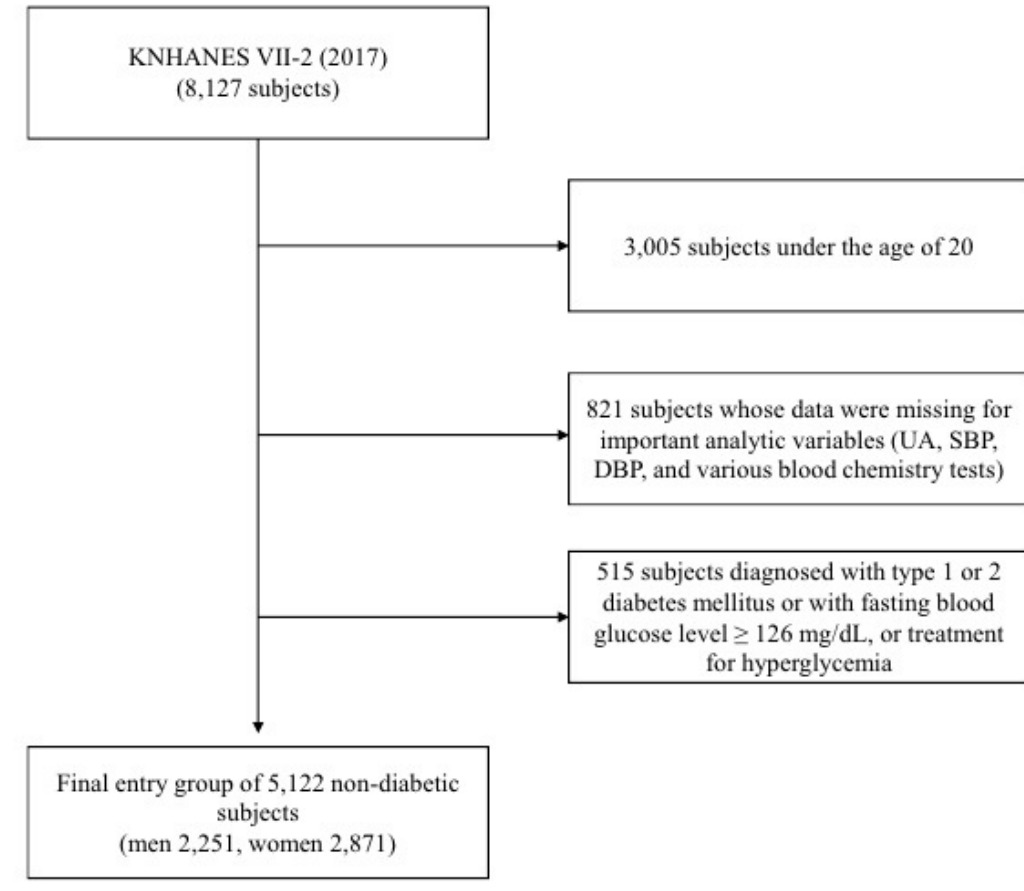
Fig. 1. Flowchart showing criteria for subject